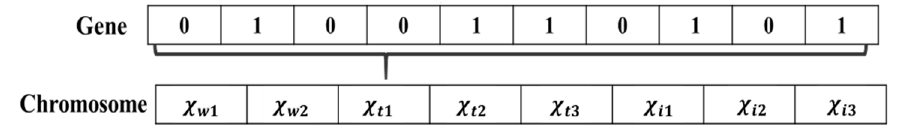
Figure 5. Binary encoding structure.